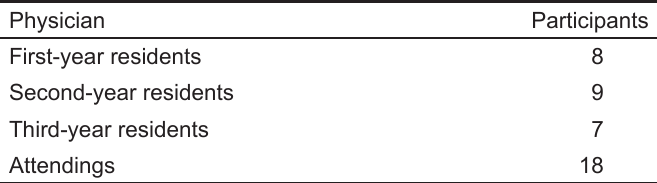
Figure. Questionnaire. Table 1. Questionnaire response rate by Emergency Medicine participants in physician-in-triage study.